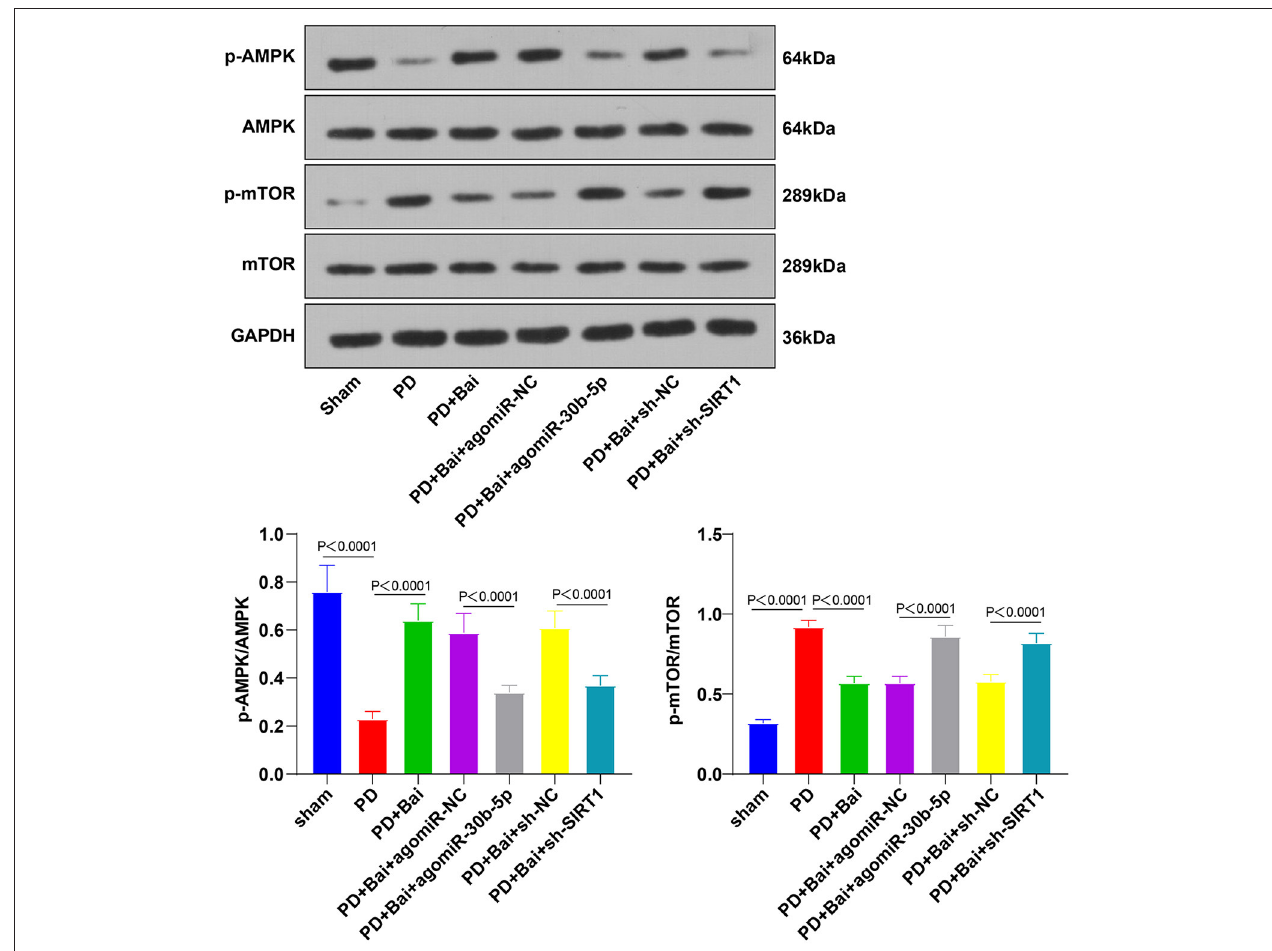
FIGURE 5 | Baicalein mediated mitochondrial autophagy via miR-30b-5p/SIRT1 and the AMPK/mTOR signaling pathway. The effect of miR-30b-5p on the AMPK/mTOR signaling pathway was observed by transfecting agomir-30b-5p in PD rats. The phosphorylation levels of AMPK and mTOR were detected by WB. N = 6. The data in the figure are all measurement data and expressed as mean ± standard deviation; one-way ANOVA was used for variance analysis among multigroups; Tukey’s test was used for the post hoc